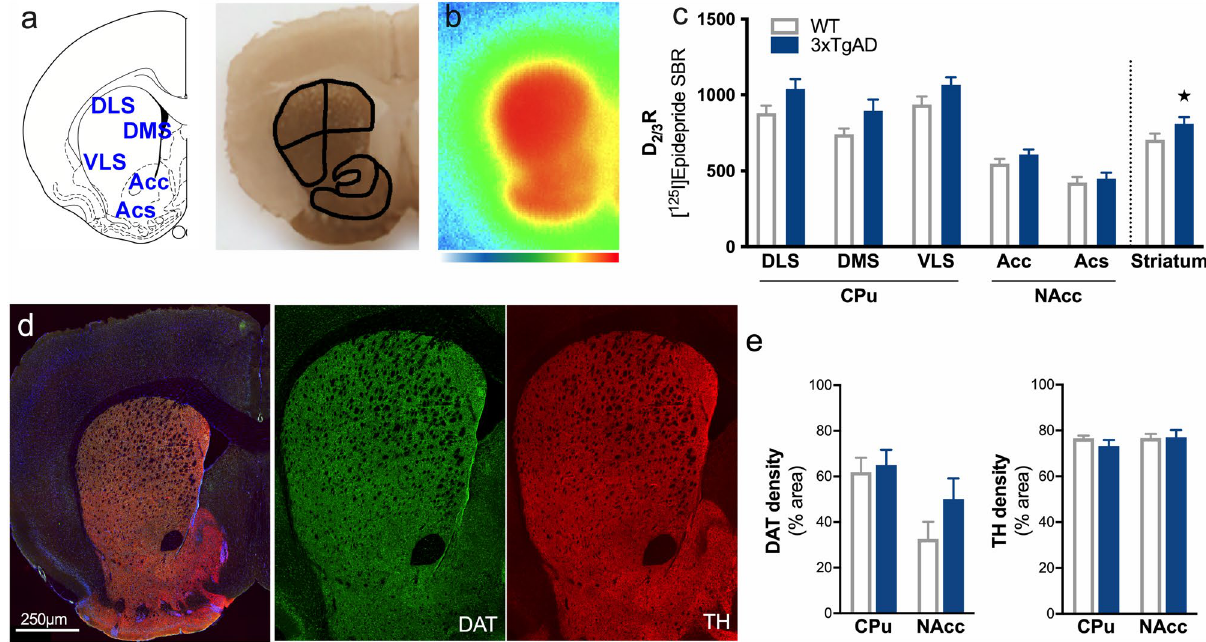
Figure 1. Increases in postsynaptic D 2/3 R in the striatum of 3xTg-AD mice. (a) Schematic representation of different areas of the striatum which have been drawn manually according to the acetylcholinesterase staining anatomy. (b) example of in situ labeling with [ 125 I]Epidepride. Color scale refers to activity in the autoradiograms (from 0 to 500 MBq/mg). (c) Assessment of D 2/3 R density by [ 125 I]Epidepride specific binding ratio (SBR) quantification. (d) Example of staining in the striatum for DAPI (blue), DAT (green) and TH (red). Left: merge image and right: images for DAT and TH. (e) Quantification of the area occupied by DAT and TH